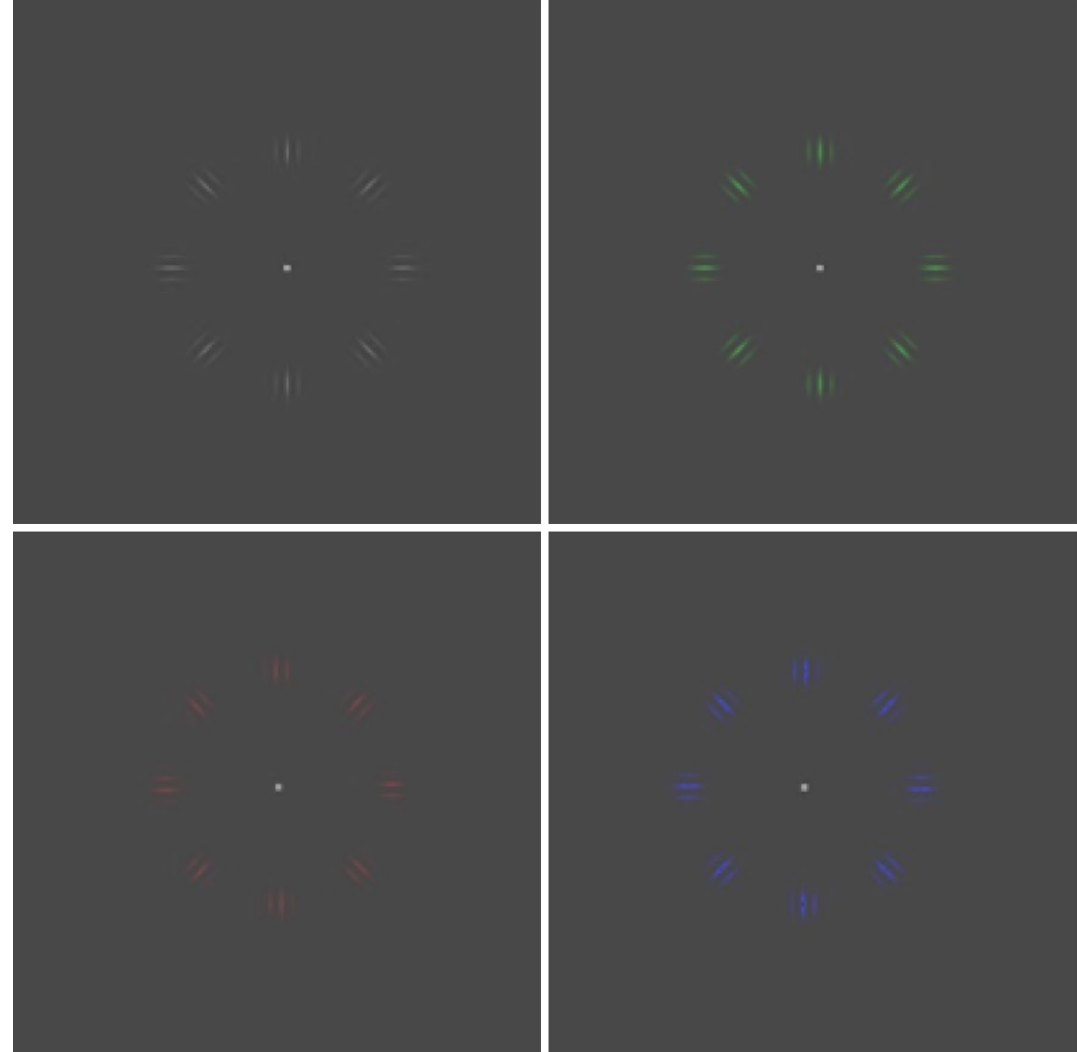
Figure 2. Images of the annulus (comprising of 8 Gabor elements) stimuli used in the present study which were either achromatic, green, red and blue in